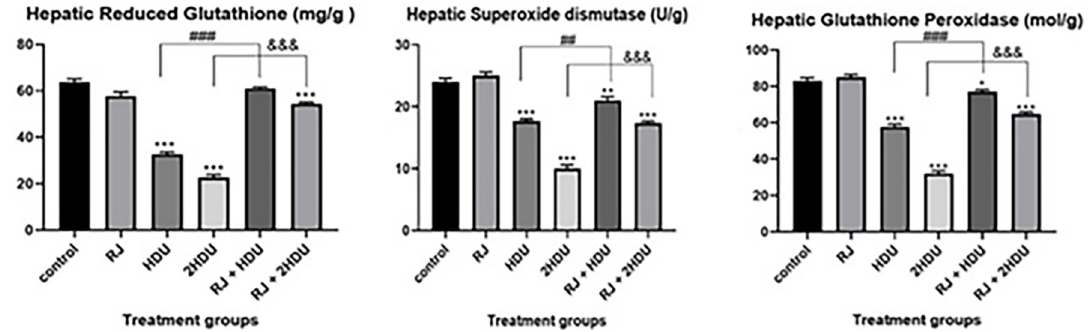
Fig 5. Effects of oral royal jelly (RJ; 100 mg/kg bwt) administration on the anti-oxidant enzymes, reduced glutathione (GSH), glutathione peroxidase (GPx), and superoxide dismutase (SOD) content in rats treated with hydroxyurea (HDU; 225 or 450 mg/ kg bwt) for 60 days. Data are presented as the mean ± SEM. Compared to the control, significance at (p < 0.001) ��� (ANOVA with Dunnett’s multiple comparison test). Compared to HDU treated groups using Unpaired t-test, significance at p < 0.01 ## and p < 0.001 &&& for HDU and 2HDU groups,